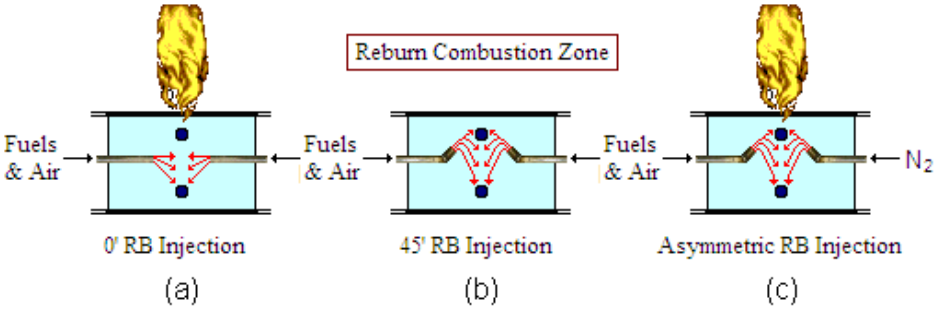
Figure 3. Injection configurations of reburn fuels: ( a ) Symmetric lateral (0°) injection, ( b ) Symmetric 45° upward injections and ( c ) Asymmetric 45° upward injection with air and N 2 .